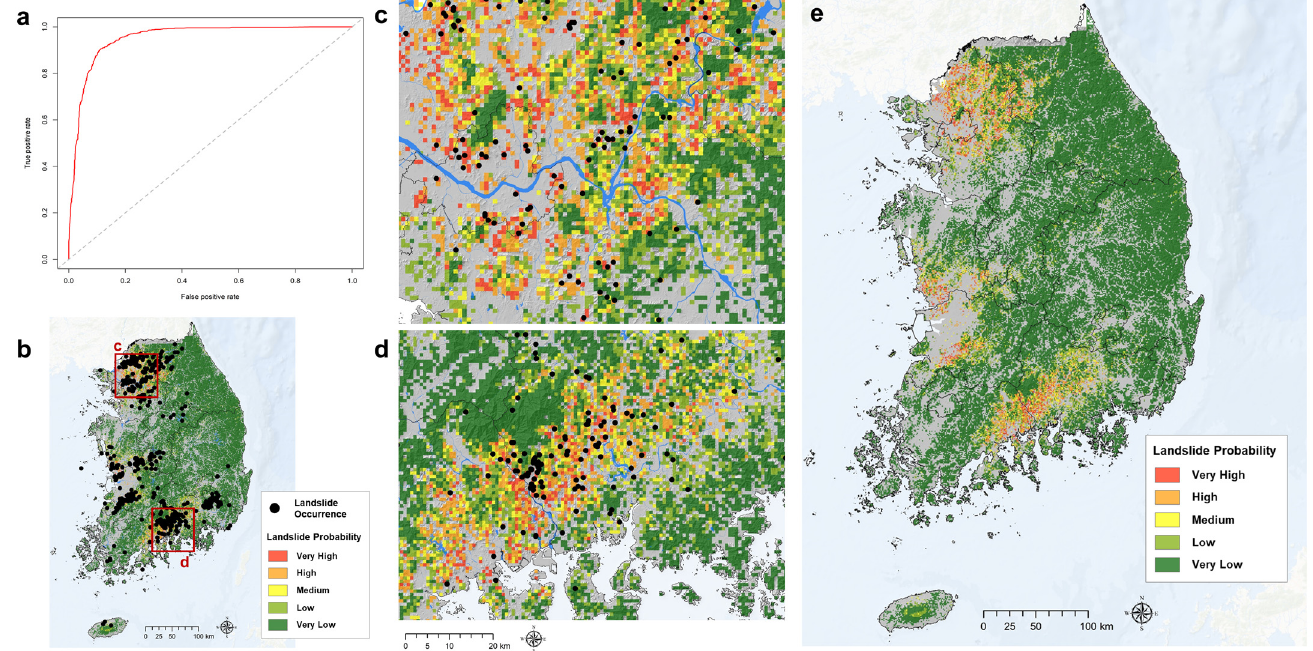
Figure 5. Model evaluation and baseline prediction of landslide probability: ( a ) ROC curve, ( b ) pre- diction result and overlaying occurrence data, ( c ) close-up view of the main hazardous region—Seoul, ( d ) close-up view of the main hazardous region—southern coastal region, and ( e ) result of landslide probability prediction. Table 3. Importance of variables used in baseline prediction.